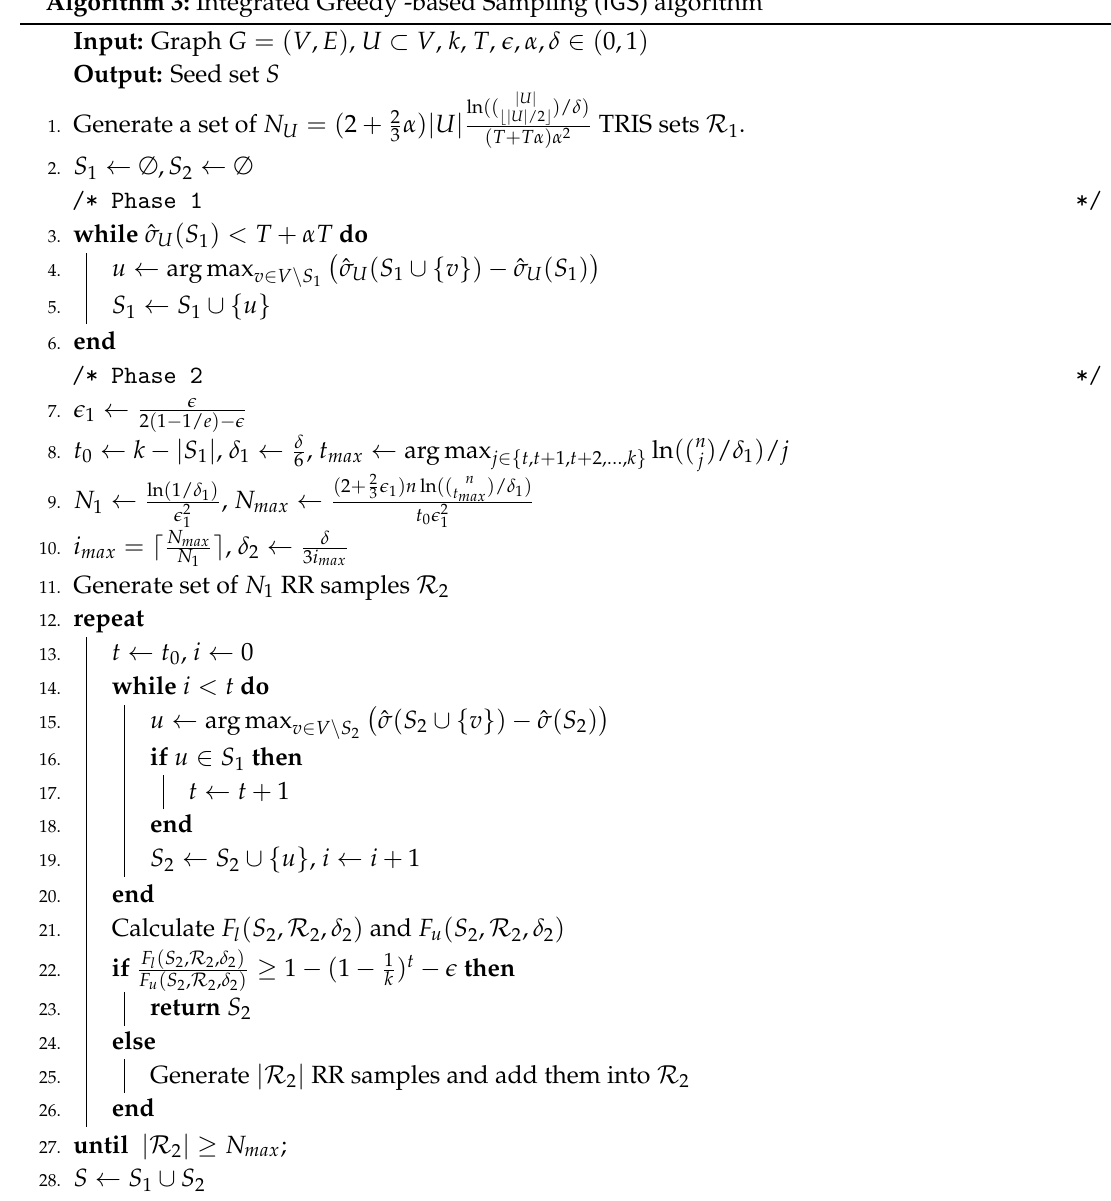
Algorithm 3: Integrated Greedy -based Sampling ( IGS )